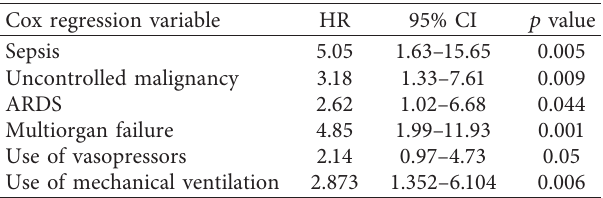
Table 3: Multivariate analysis of ICU